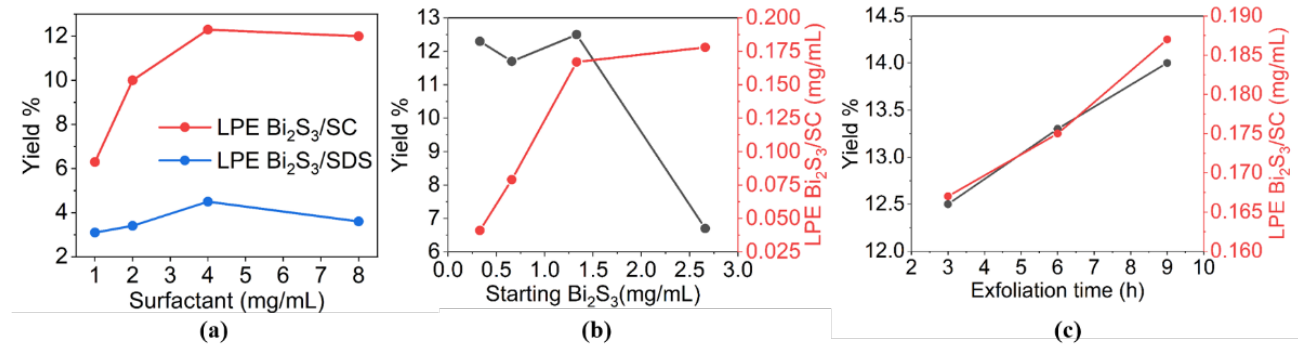
Figure 3. Optimization of the surfactant-assisted LPE process for Bi 2 S 3 . ( a ) Yield in nano-sized LPE Bi 2 S 3 with different types and concentrations of surfactants (SC red line, SDS blue line) determined starting from 0.33 mg/mL of bulk Bi 2 S 3 and exfoliation time of 3 h. ( b ) Exfoliation yield (black line) and concentration of LPE Bi 2 S 3 in 4 mg/mL of SC/H 2 O suspensions (red line) with different concentrations of starting bulk Bi 2 S 3 (exfoliation time = 3 h). ( c ) Exfoliation yield (black line) and concentration of LPE Bi 2 S 3 in 4 mg/mL SC/H 2 O suspensions (red line) after different exfoliation times (starting Bi 2 S 3 concentration = 1.5